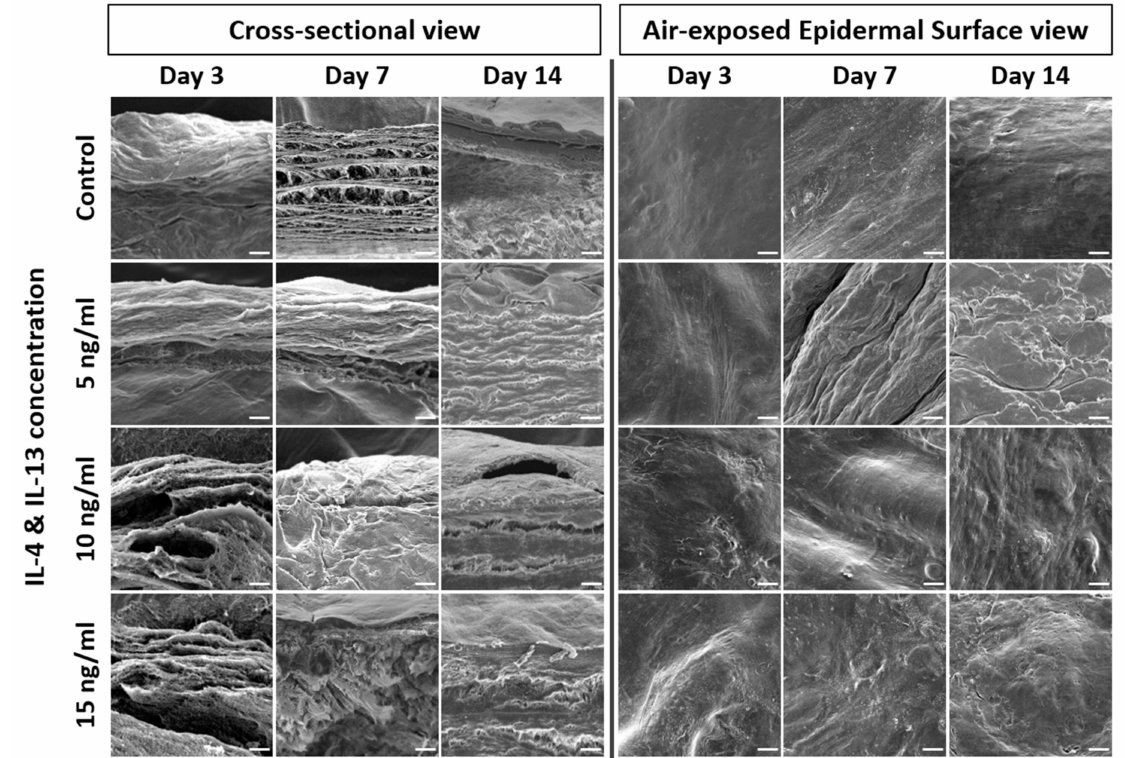
Figure 4. SEM of AD-HSE. SEM of cross-sectional and air-exposed epidermal surface views of AD-HSE stimulated with IL-4/IL-13 for 3, 7 and 14 days. Scale bar is 20 µ